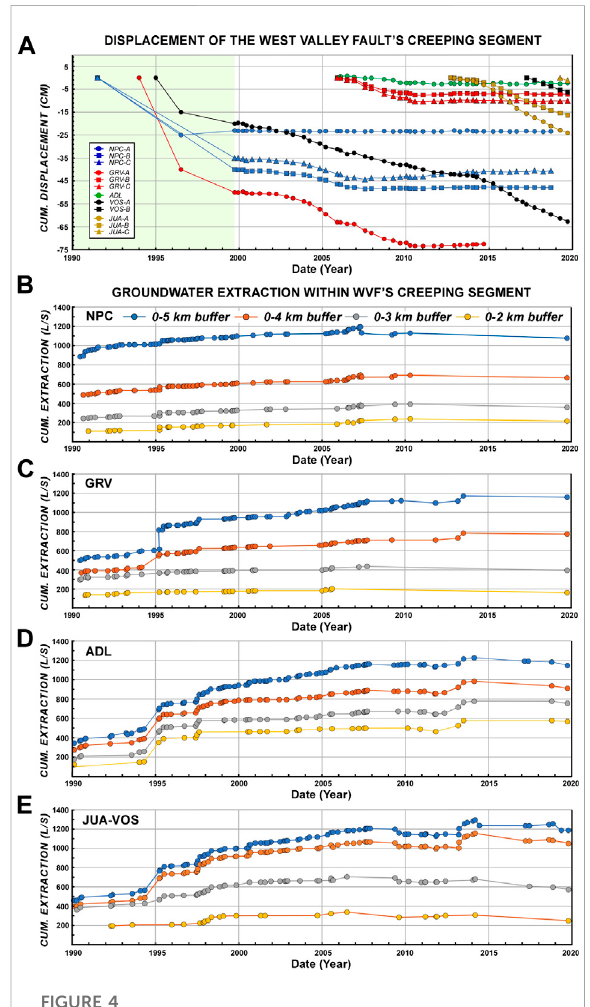
FIGURE 4 (A) Combined plot of differential displacement from the 1990s (left partof theplot) and from1999 to 2019 (right part ofthe plot) for the 12 survey lines across creeping segments in fi ve sites (NPC, GRV,ADL,VOS,andJUA;seeFigures1,2forlocations). Value for each resurvey is the difference from the displacement measured in a preceding survey. The fi rst resurvey conducted in December 1999 was preceded by the September 1999 survey. Values below zero indicate that the east side of the fault is moving down. Also shown are plots of cumulative groundwater extraction (in literspersecond orlps) within the2,3, 4,and 5 kmbufferzones centered around NPC (B) , GRV (C) , ADL (D) , and JUA-VOS (E) . (Note: multiple data points within each year included. Cumulative groundwater extraction values at any given time for each buffer zone are estimated by subtracting values from wells whose permits were canceled at the time